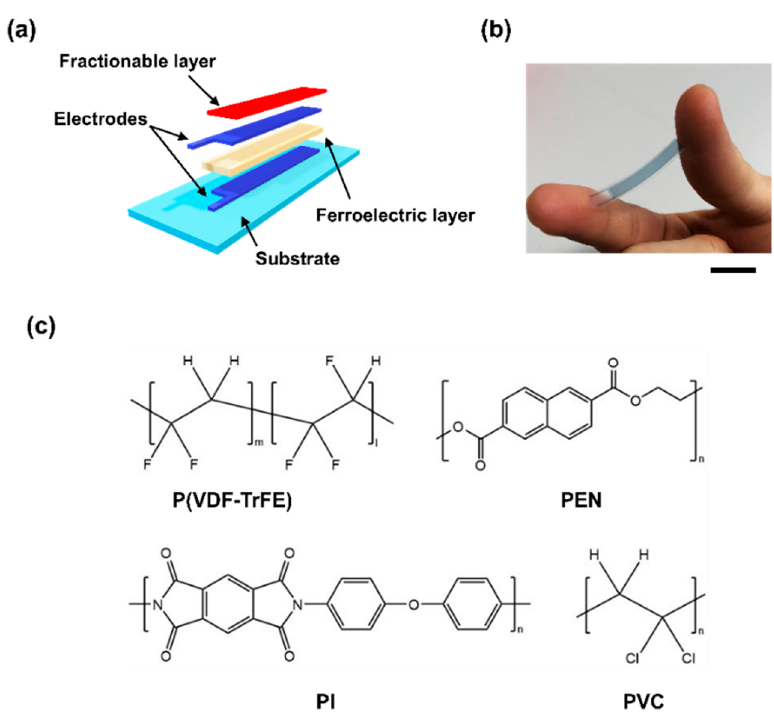
Figure 1. Soft shear force sensor fabrication: ( a ) Illustration of the fabricated sensor; ( b ) Photo of the sensor, scale bar = 5 cm; ( c ) Chemical structures of the ferroelectric and passivation layer materials. poly(vinylidene fluoride-co-trifluoroethylene): (P(VDF-TrFE)); poly(ethylene naphthalate): (PEN); polyimide: (PI); polyvinyl chloride: (PVC).